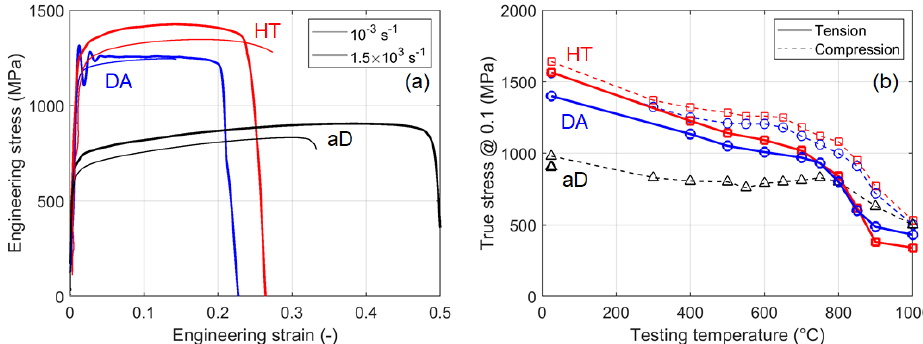
Fig. 6. (a) Engineering stress versus engineering strain curves at room temperature in quasi-static and high strain rate conditions for aD, DA and HT specimens; (b) true stress as a function of the testing temperature at 0.1 of true